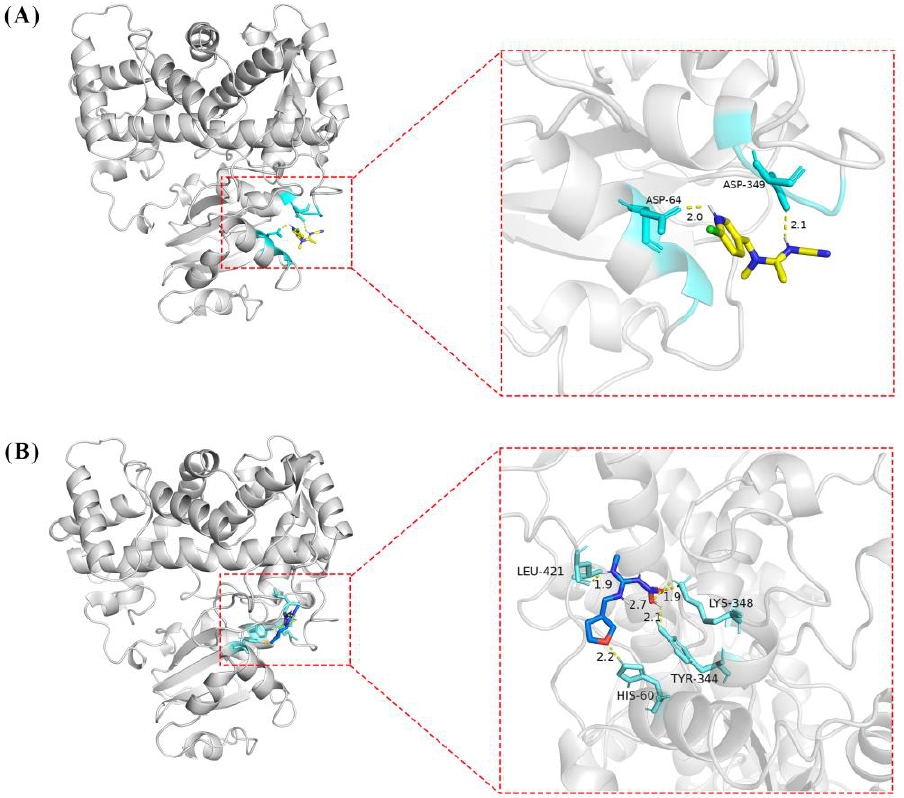
Figure 5. The tertiary structure of CYP6ER1 and its docking structure with acetamiprid ( A ) and dinotefuran ( B ).